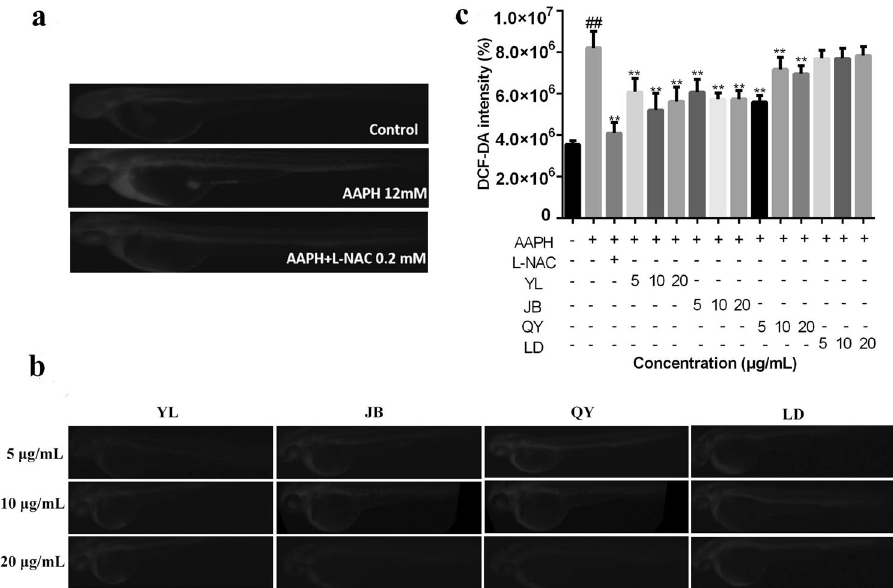
Figure 8. Determination of ROS levels in zebrafish larvae from 48 hpf in Control group, AAPH-treatment group, AAPH + L-NAC-treatment group ( a ); Determination of ROS levels in zebrafish larvae from 48 hpf after treatment with YL-thyme oil, JB-thyme oil, QY-thyme oil and LD-thyme oil ( b ); Determination of mean DCF fluorescence intensity by Image analysis ( c ). The values are expressed as mean ± SD ( n = 15). * Represents p